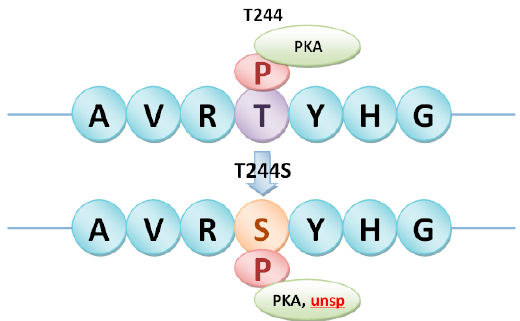
Figure 5. Type IV phosSNP, T244S, in heterotrimeric G β subunit (LOC_Os03g46650), which induced the substitution between Thr and Ser in the protein phosphorylation site T244 and changed kinase types of the target site. The red marks represented the different kinase types caused by phosSNPs; The same as below. PKA: Protein kinase A; unsp: non-specific prediction kinase.